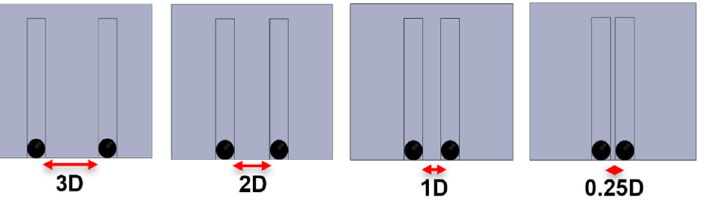
Figure 2. Configurations of initial separation distances between particles using two back-to-back laser-cut PMMA plates.